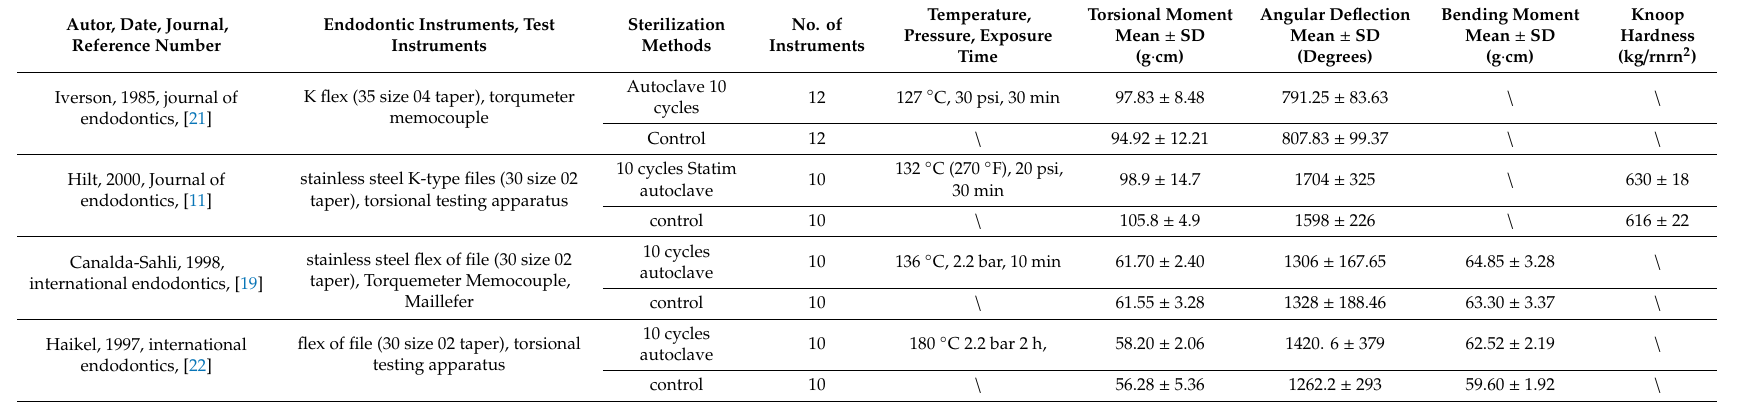
Table 4. Extracted data from selected studies (tertiary outcome and quaternary